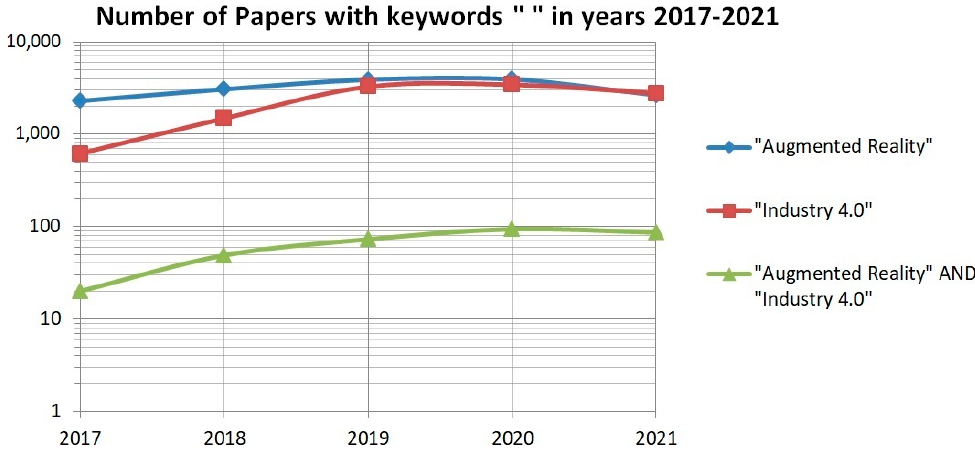
Figure 1. Trend of the number of published papers with keywords “Augmented Reality”, “Industry 4.0” and “Augmented Reality” AND “Industry 4.0” from Scopus database.